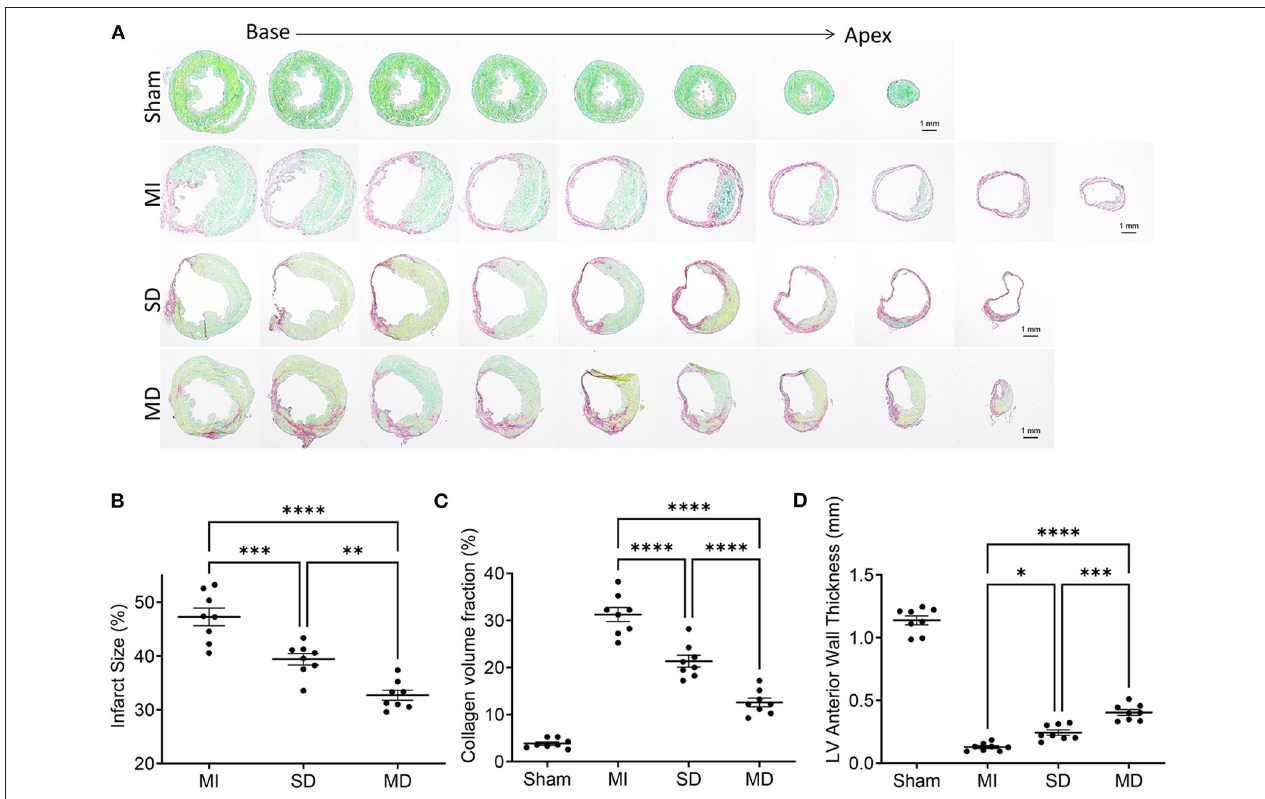
FIGURE 4 | Evaluation of infarct size, collagen volume, and left ventricular morphology. The fibrotic (red; inactive) and non-fibrotic (green; active) areas of ventricular tissue sections were shown by Sirius Red/Fast Green histochemical staining (A) and quantification of infarct size (B) , collagen volume fraction (C) , and LV anterior wall thickness (D) in posttreatment week 4. Data are means ± SE. Eight animals per group. Scale bar = 1mm. One-way ANOVA with Dunn’s multiple comparisons test. * p < 0.05; ** p < 0.01; *** p < 0.001; **** p < 0.0001.